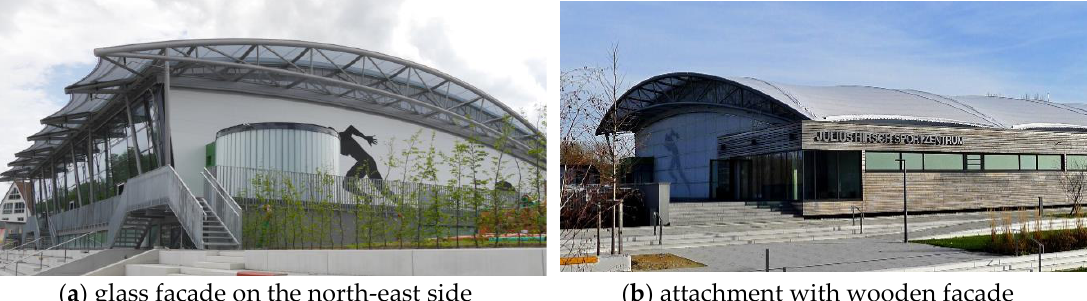
Figure 1. Photographs of the case study building from: ( a ) north; and ( b ) west.